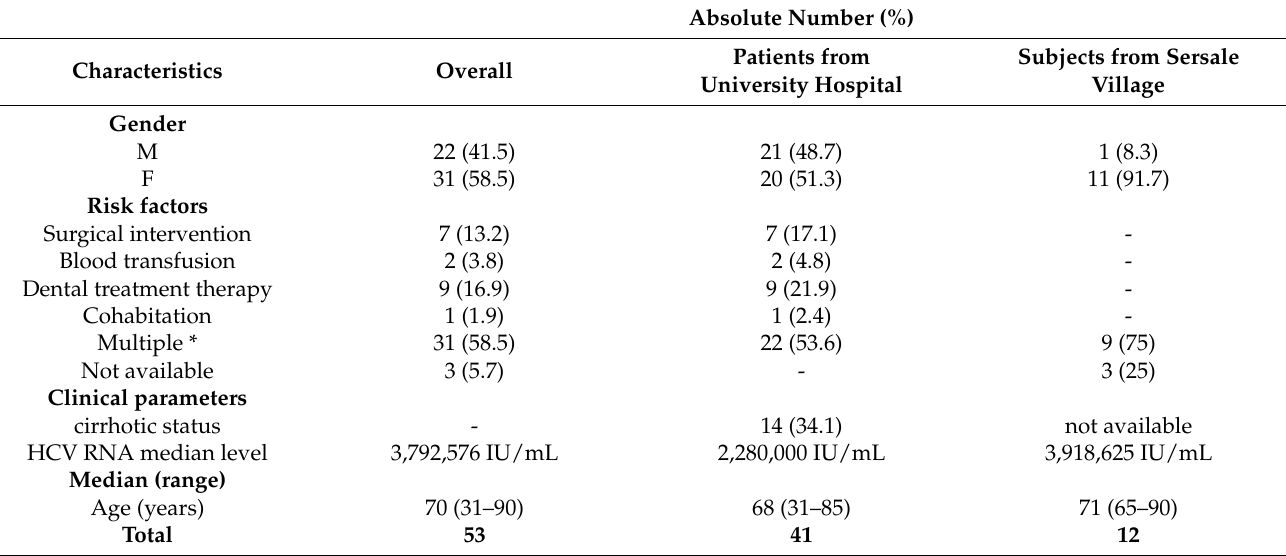
Table 1. Patient demographic